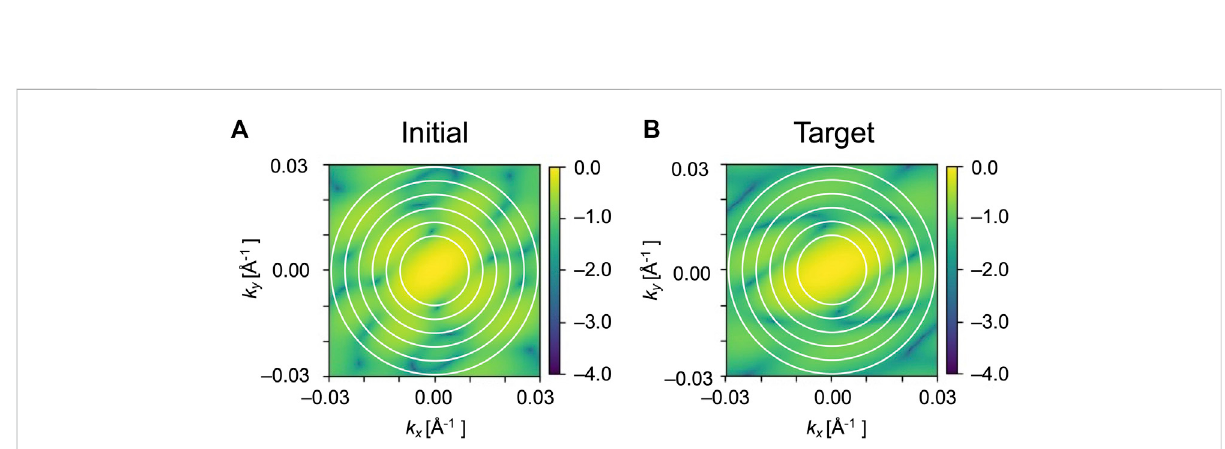
FIGURE 4 Circlematchingregioninthediffractionpatterns.Onlythecircles fi lledwithwhitewereusedforthecalculationsofPearsoncorrelation. (A) and (B) are simulated diffraction patterns of initial and target GMM models of EF2, respectively. The radii of the circles on the patterns are 0.010, 0.014, 0.018, 0.022, 0.026 and 0.030 Å − 1